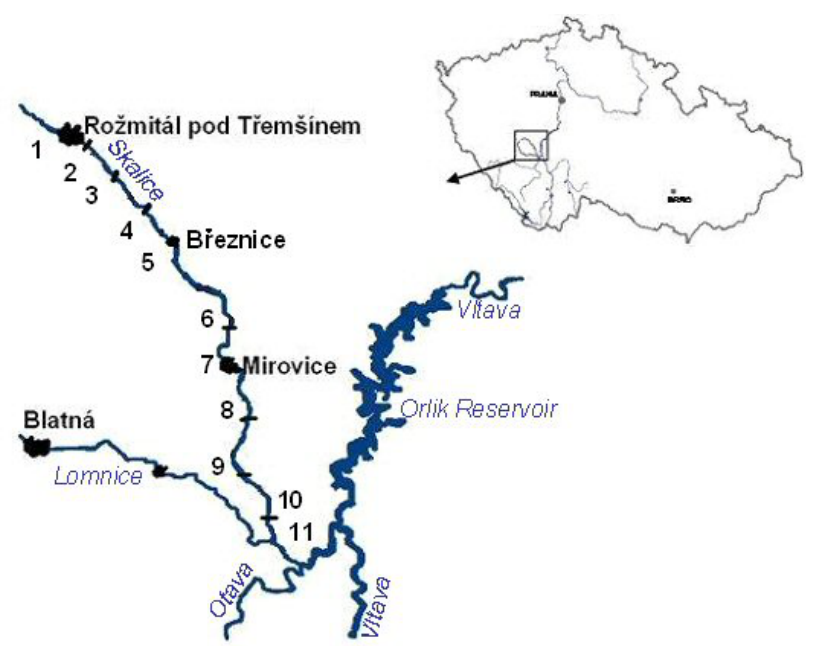
Figure 4. Locations of sites (Czech